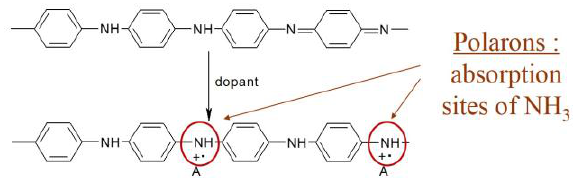
Figure 1. Polyaniline structure and ammonia interaction.